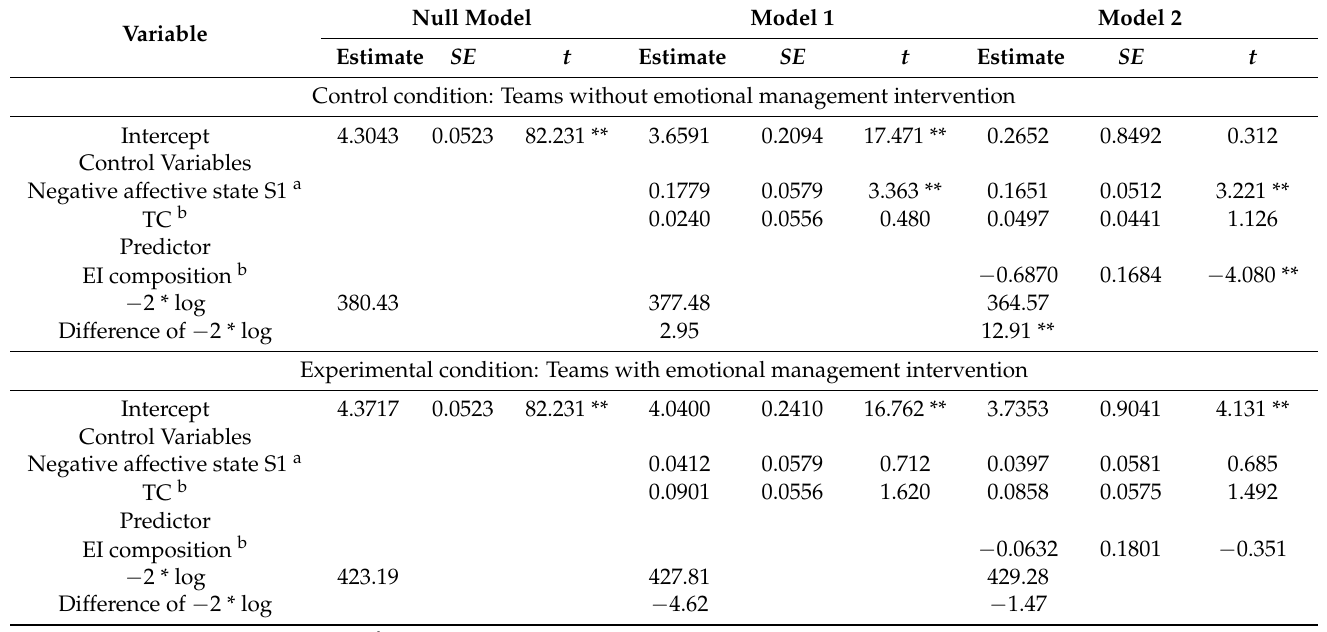
Table 5. Multilevel estimates for models predicting negative affective states in Session